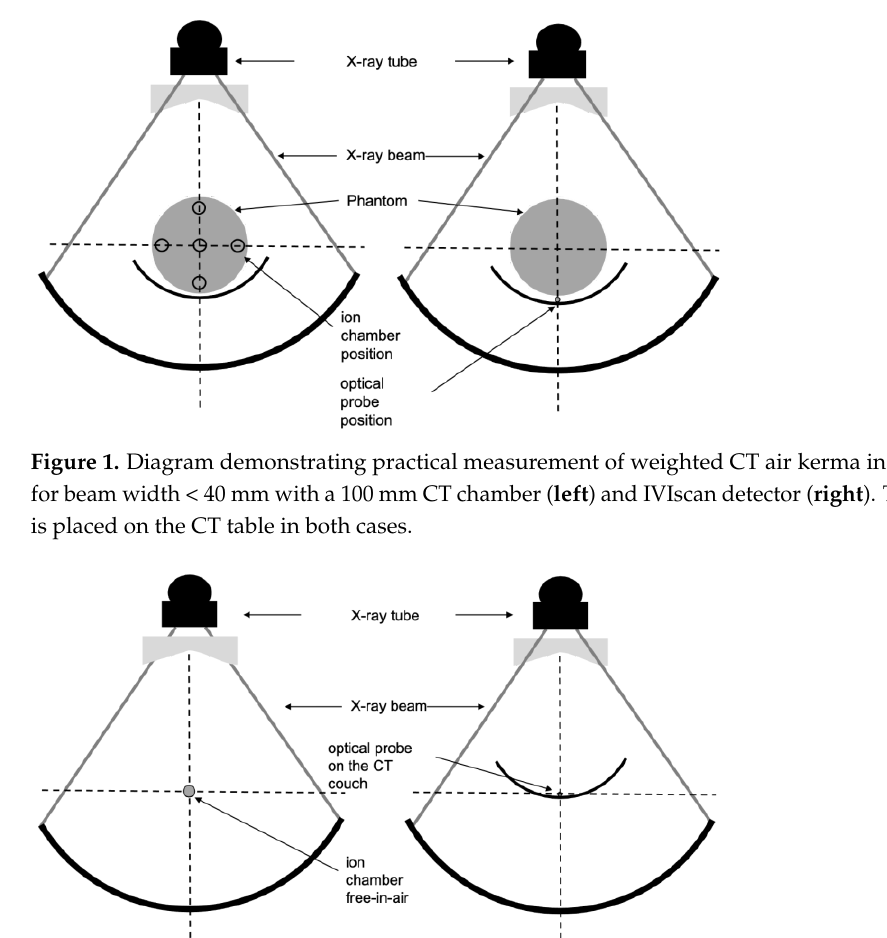
Figure 2. Diagram demonstrating practical measurement of the CT air kerma indexes measured ( CTDI air , N × T > 40 ) for beam width N × T larger than 40 mm with a 100 mm CT chamber free-in-air ( left ) and with IVIscan detector on the CT table ( right ). No phantom is used here.